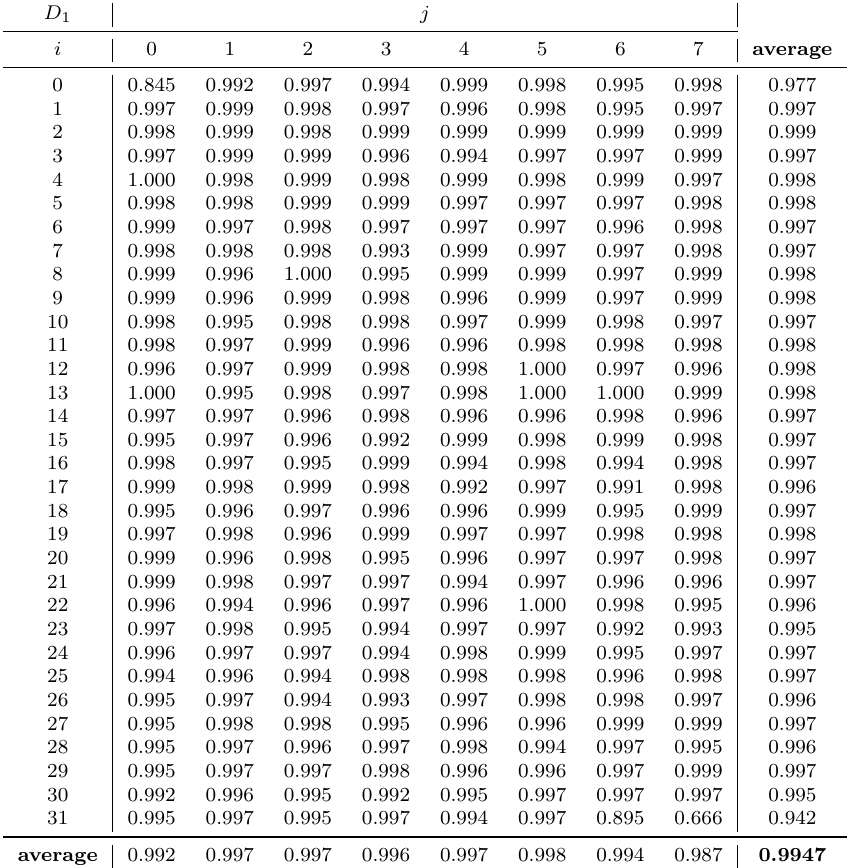
Table 15: Empirical probability to recover the message bit m [8 i + j ] from a single trace using poly_A2A() . Average results for 1K traces from device D 1 (profiling). D 1